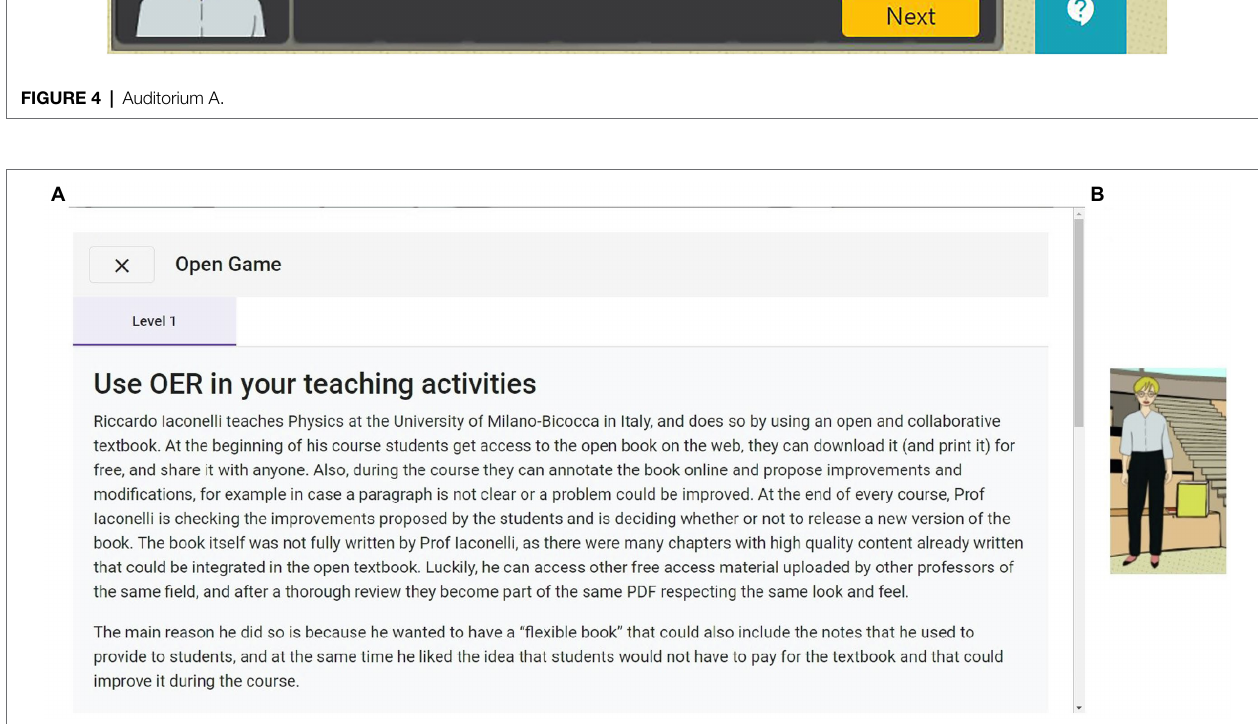
FIGURE 5 | (A) Partial view of the open practice presented to the user; (B) highlighted book to show where the user has to click